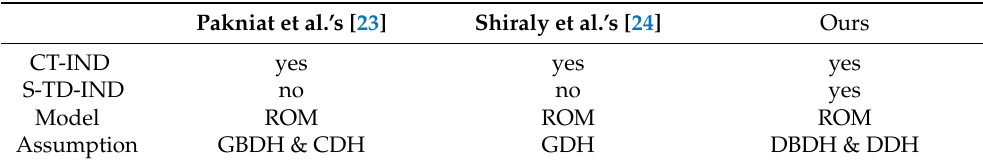
Table 4. Security